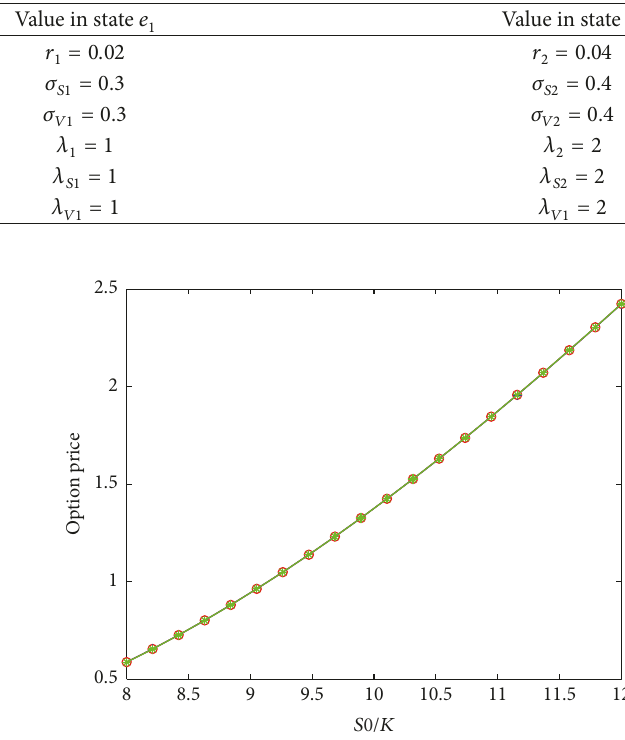
Table 2: Parameters that depend on the Markov chain.